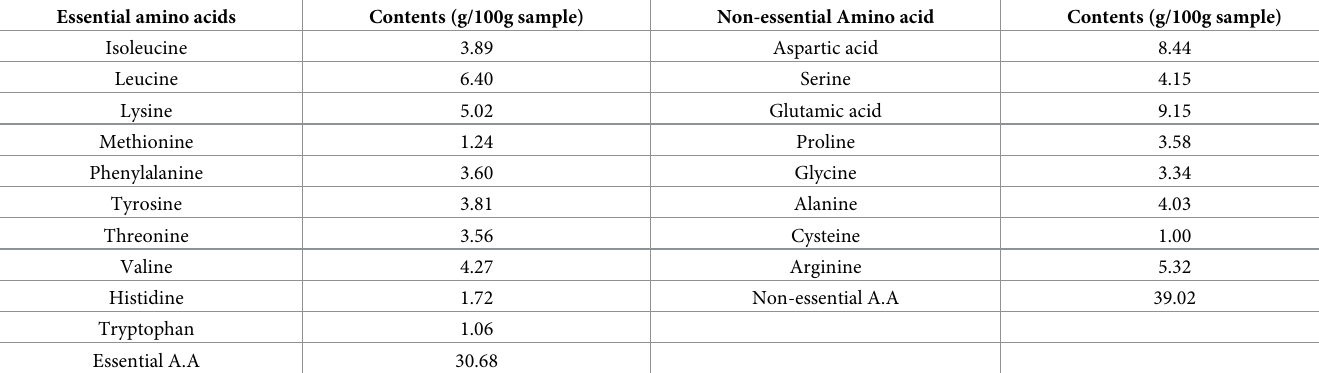
Table 3. Amino acid composition (g/100 g sample) for the protein isolate of G . bimaculatus .